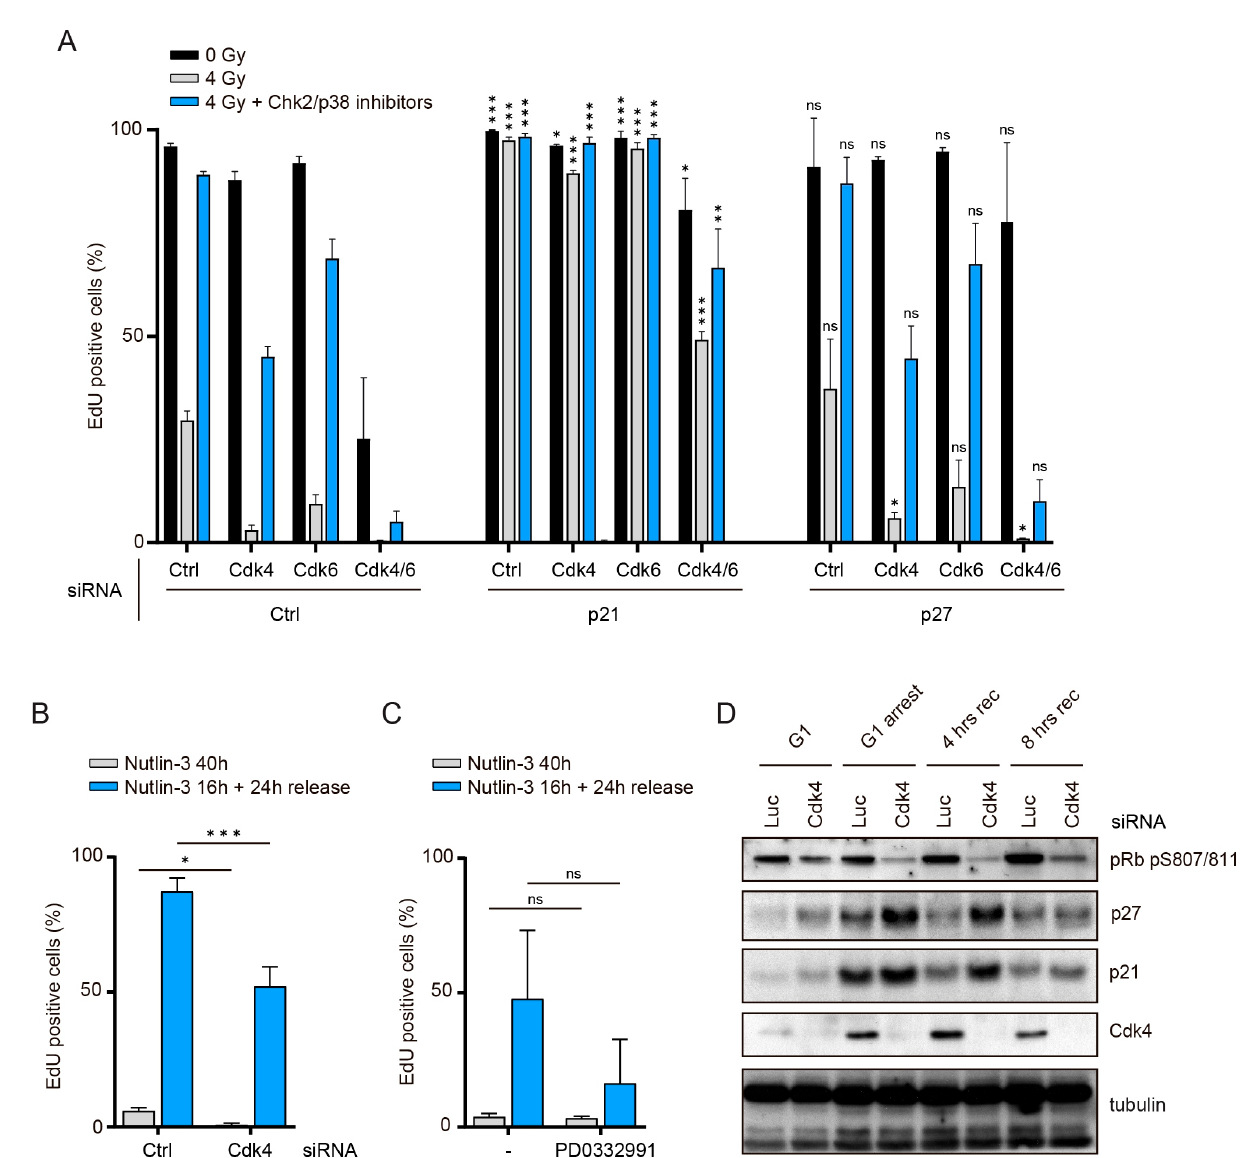
Figure 3. Regulation of p21 and p27 Cdk inhibitors in G1 recovery: ( A ) RPE-1 cells were transfected with the indicated siRNA during serum starvation and G1 recovery was assessed as in 1A. Depicted are the means and SD of two independent experiments. Significance was calculated by comparing the knock-down of different Cyclin-dependent kinases (Cdks)